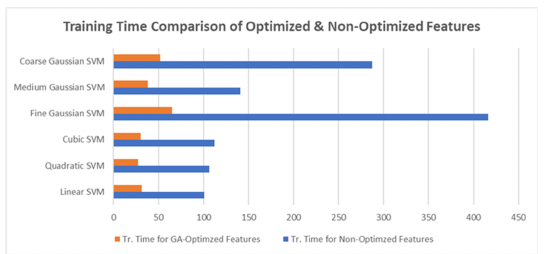
Figure 11. Graphical comparison of various SVM kernels on non-GA-optimized